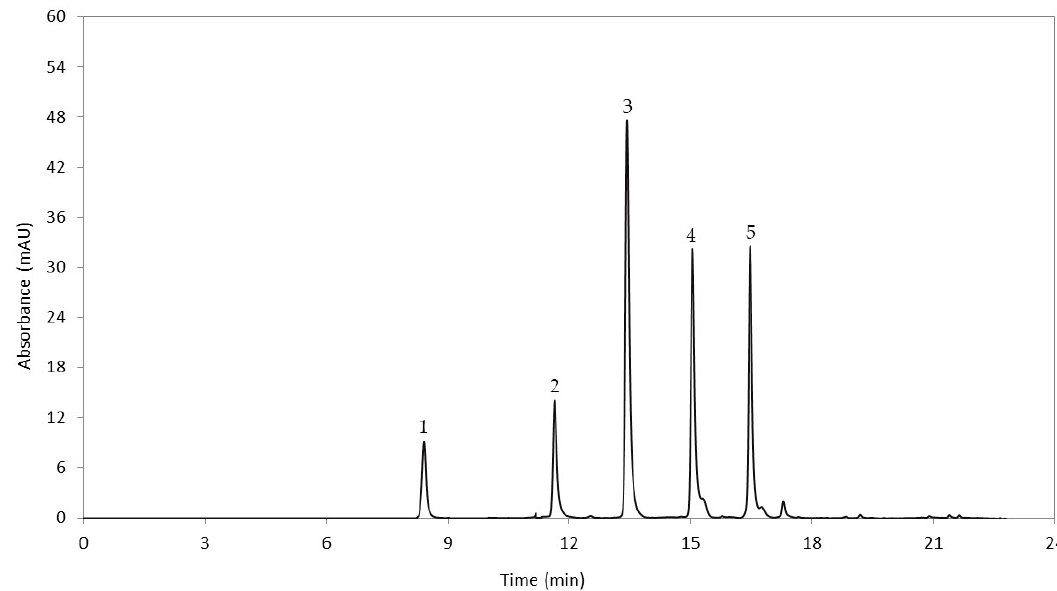
Figure 1. Chromatographic profile of anthocyanidins in the genotype CCC023 recorded at 520 nm.